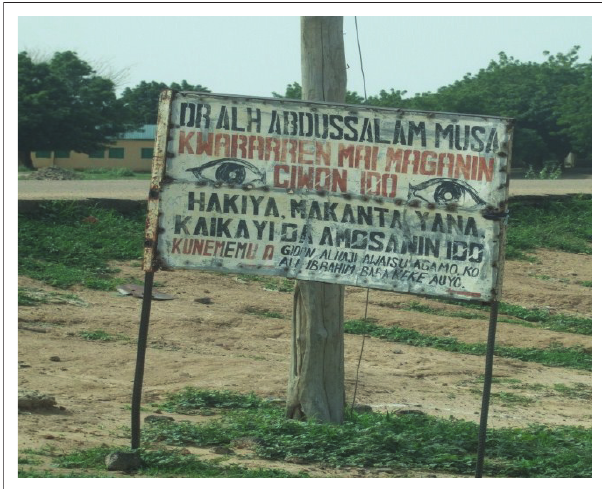
FIGURE 2: Coucher’s advertisement which says: ‘… Specialist eye doctor … corneal ulcer, cataract blindness, itching and dandruff of the eye’ (which is thought to cause cataracts). Note that the white pupils illustrate cataract